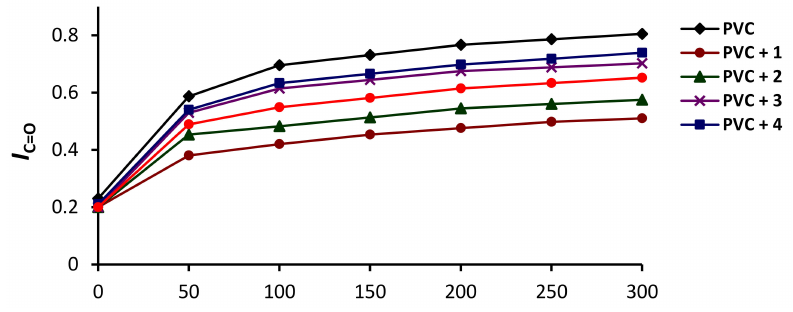
Figure 4. Changes in the I C=O of PVC upon irradiation.